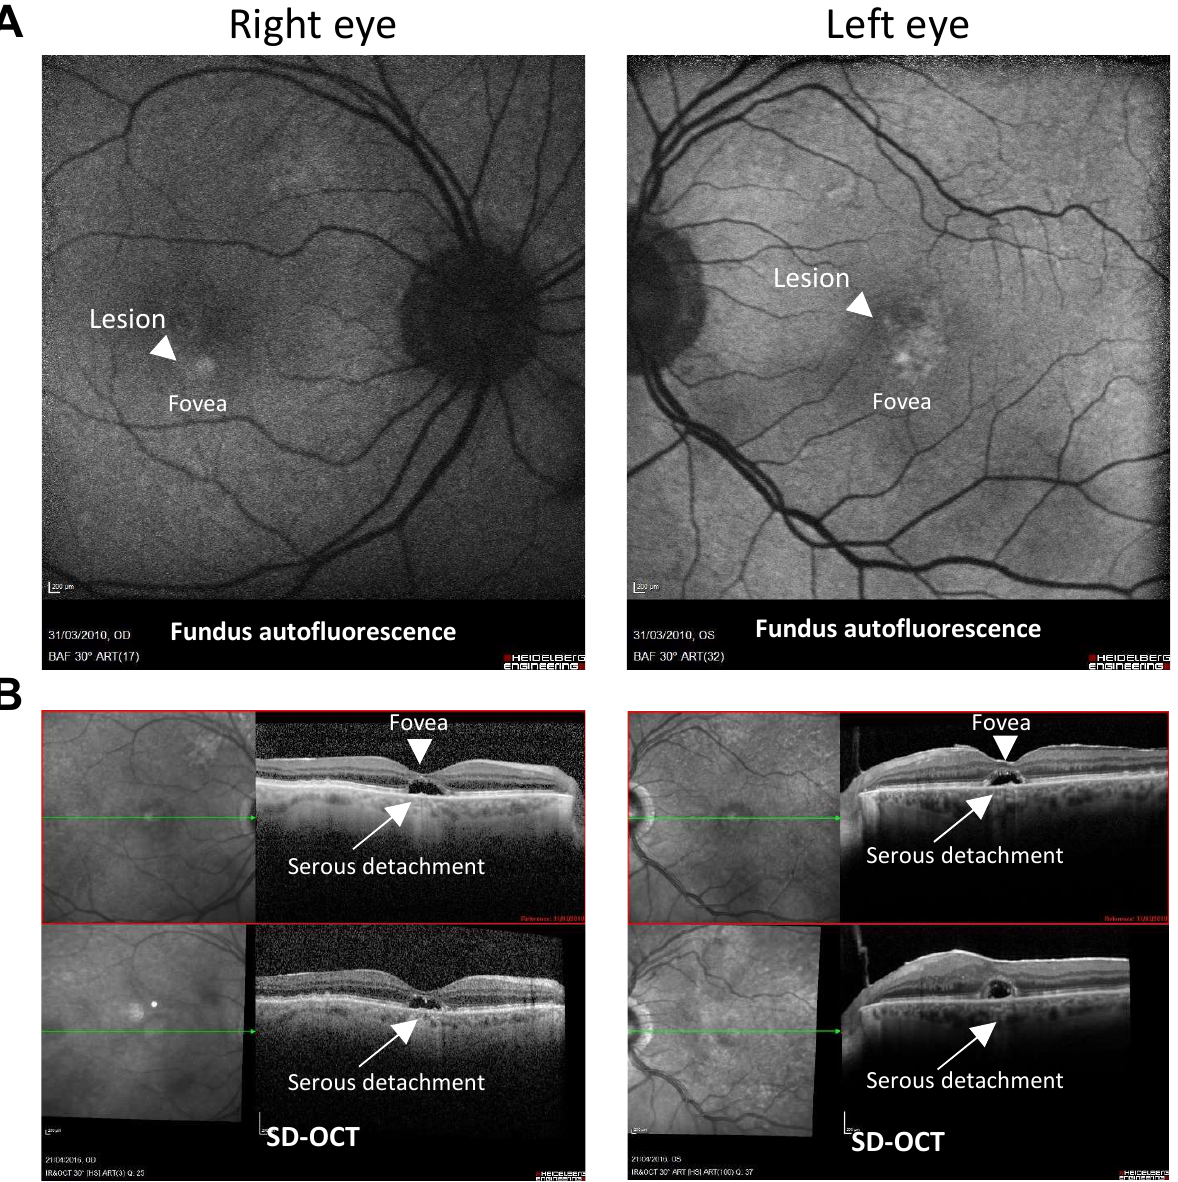
Figure 1. Clinical characteristics of the adult onset foveal vitelliform dystrophy (AFVD) patient #4024 carrying two copies of the SLC16A8 allele rs77968014-G. ( A ) Fundus autofluorescence imaging shows a bilateral lesion of the fovea. ( B ) Spectral domain optical coherence tomography (SD-OCT) shows a bilateral dome-shaped hyperreflective subretinal lesion (serous lesion) corresponding to the lesion seen by autofluorescence in ( A ). Scale bar: 200 µ